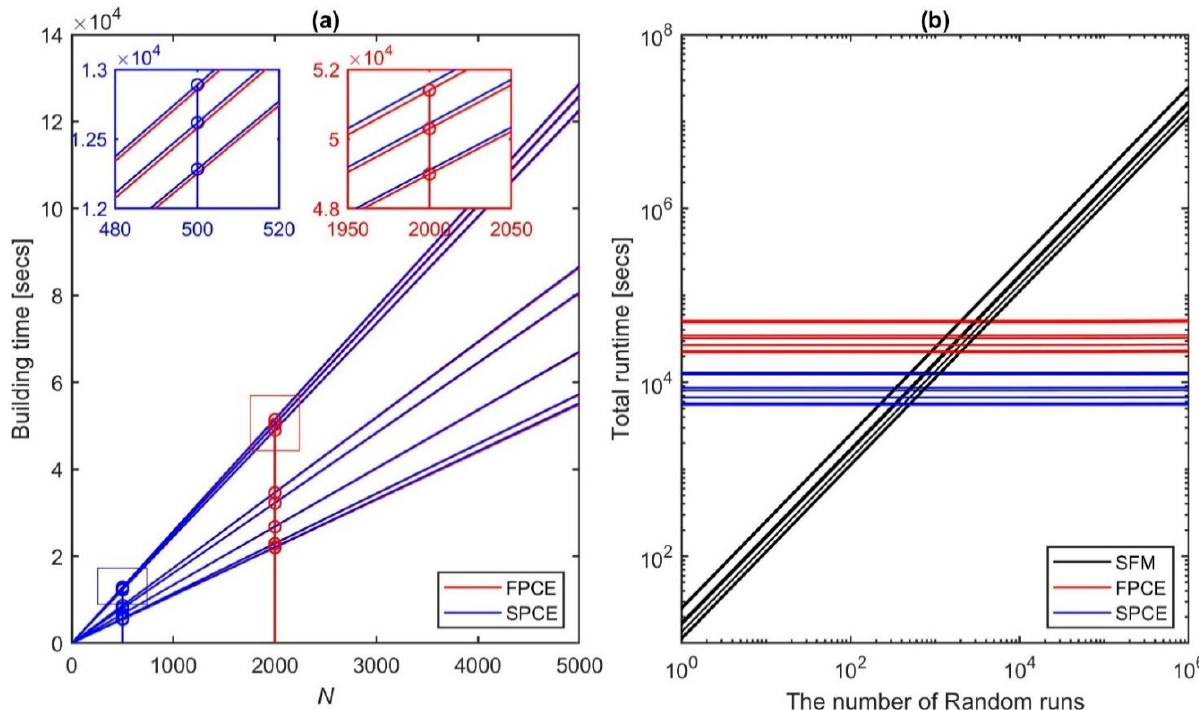
Figure 9. ( a ) Building time of FPCE and SPCE versus the size of experimental design (N) for nine streamflow events. The building times at the optimal N = 2000 for FPCE and at N = 500 for SPCE are used for sub-figure ( b ) (see the stem plots and zoom-in sub-boxes in sub-figure ( a )). ( b ) Total runtime needed for carrying out the number of model (SFM, FPCE, and SPCE) runs (from 1 to 1,000,000 on x-axis) for the nine events. Note that the intercepts of FPCE and SPCE in sub-figure ( b ) are equal to the building times computed in sub-figure ( a ), and the intercepts of SFM are zero. Table 5. Comparisons of the total runtime for nine streamflow events. The total runtime consists